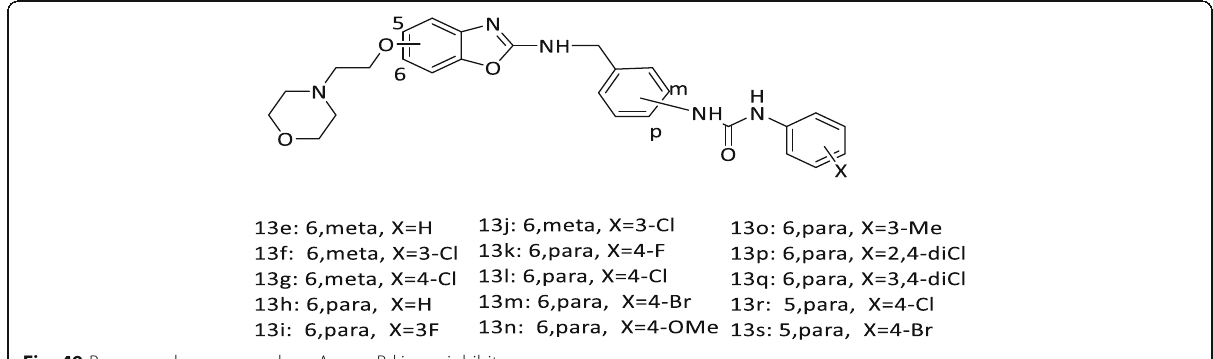
Fig. 49 Benzoxazole compounds as Aurora-B kinase